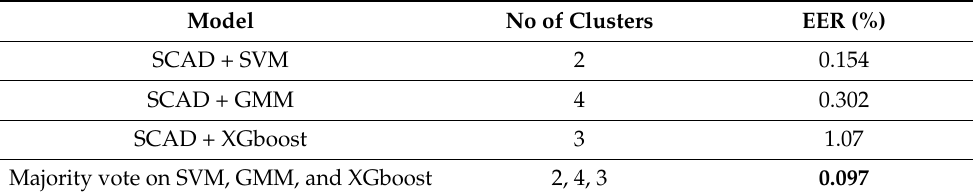
Majority vote on SVM, GMM, and